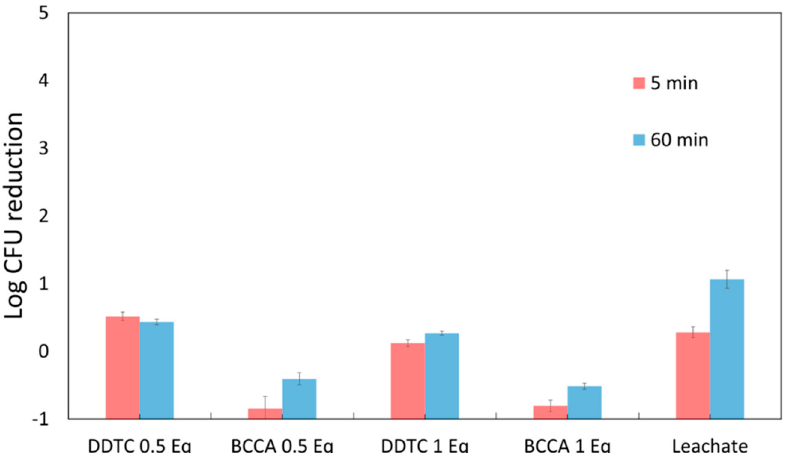
Figure 5. The activity of Cu 2 O leachate on MRSA in suspensions containing both leachate and suspended MRSA. 0.5 Eq. means that the amount of the chelating agent was 0.5 of the amount needed to chelate all the copper ions, etc. After 60 min, the leachate achieved a 1.1 log reduction from control (p = 0.006), and solutions containing DDTC and BCCA protected MRSA from the leached ions ( p = 0.013 for DDTC and p = 0.007 BCCA for pairwise comparison with a 1-way ANOVA on the 60 min data using treatment as the sole factor).